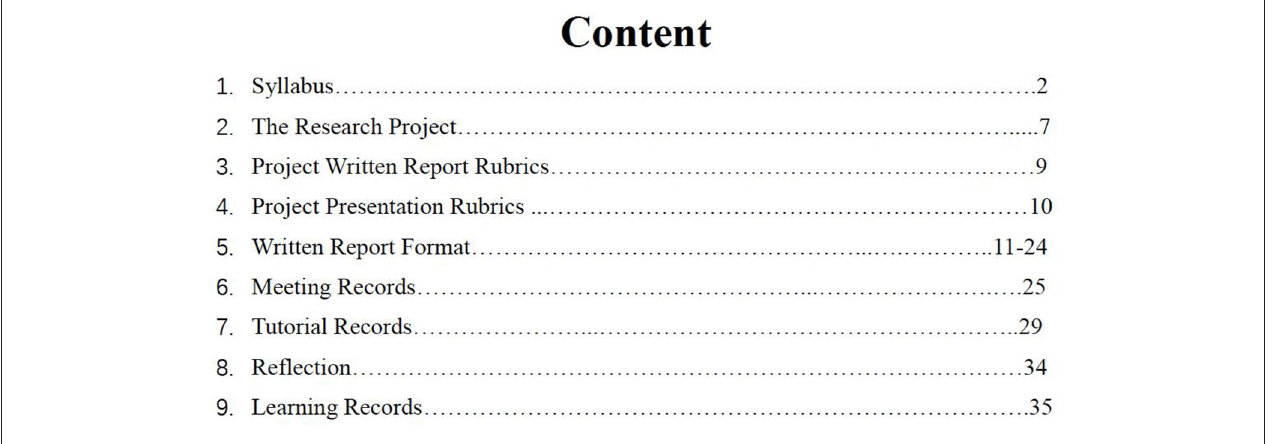
FIGURE 1 | Snapshot of the Content of Lin’s Student